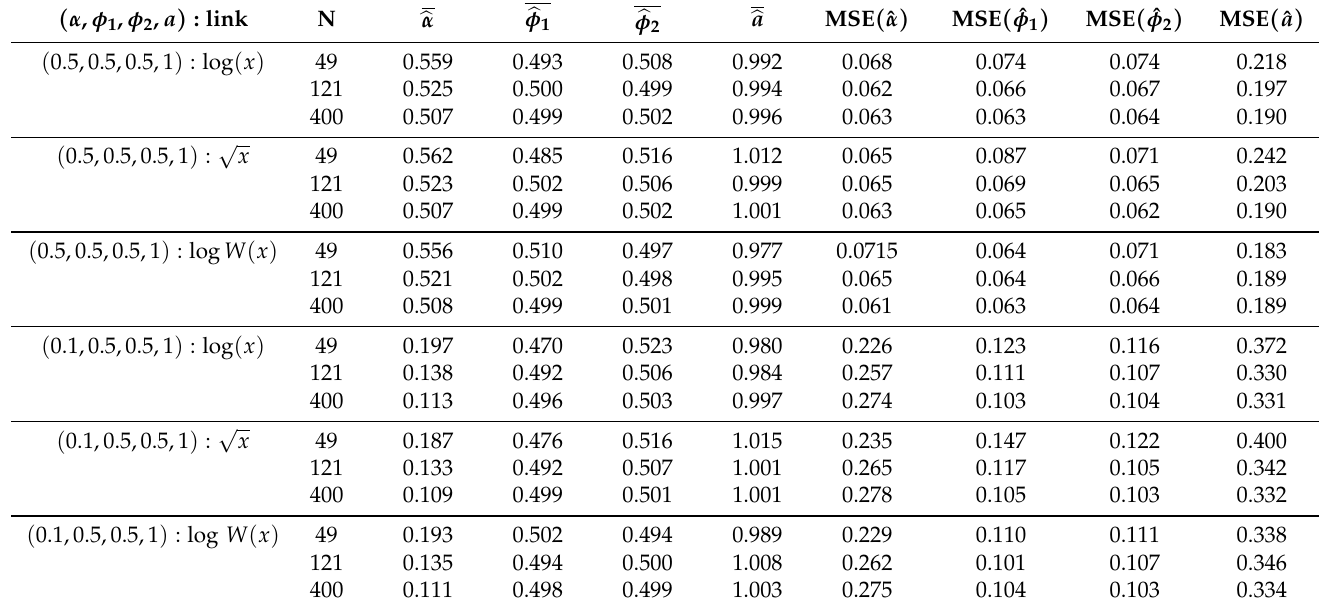
Table 1. Simulation results for the sMuth–ARMA(1,1)